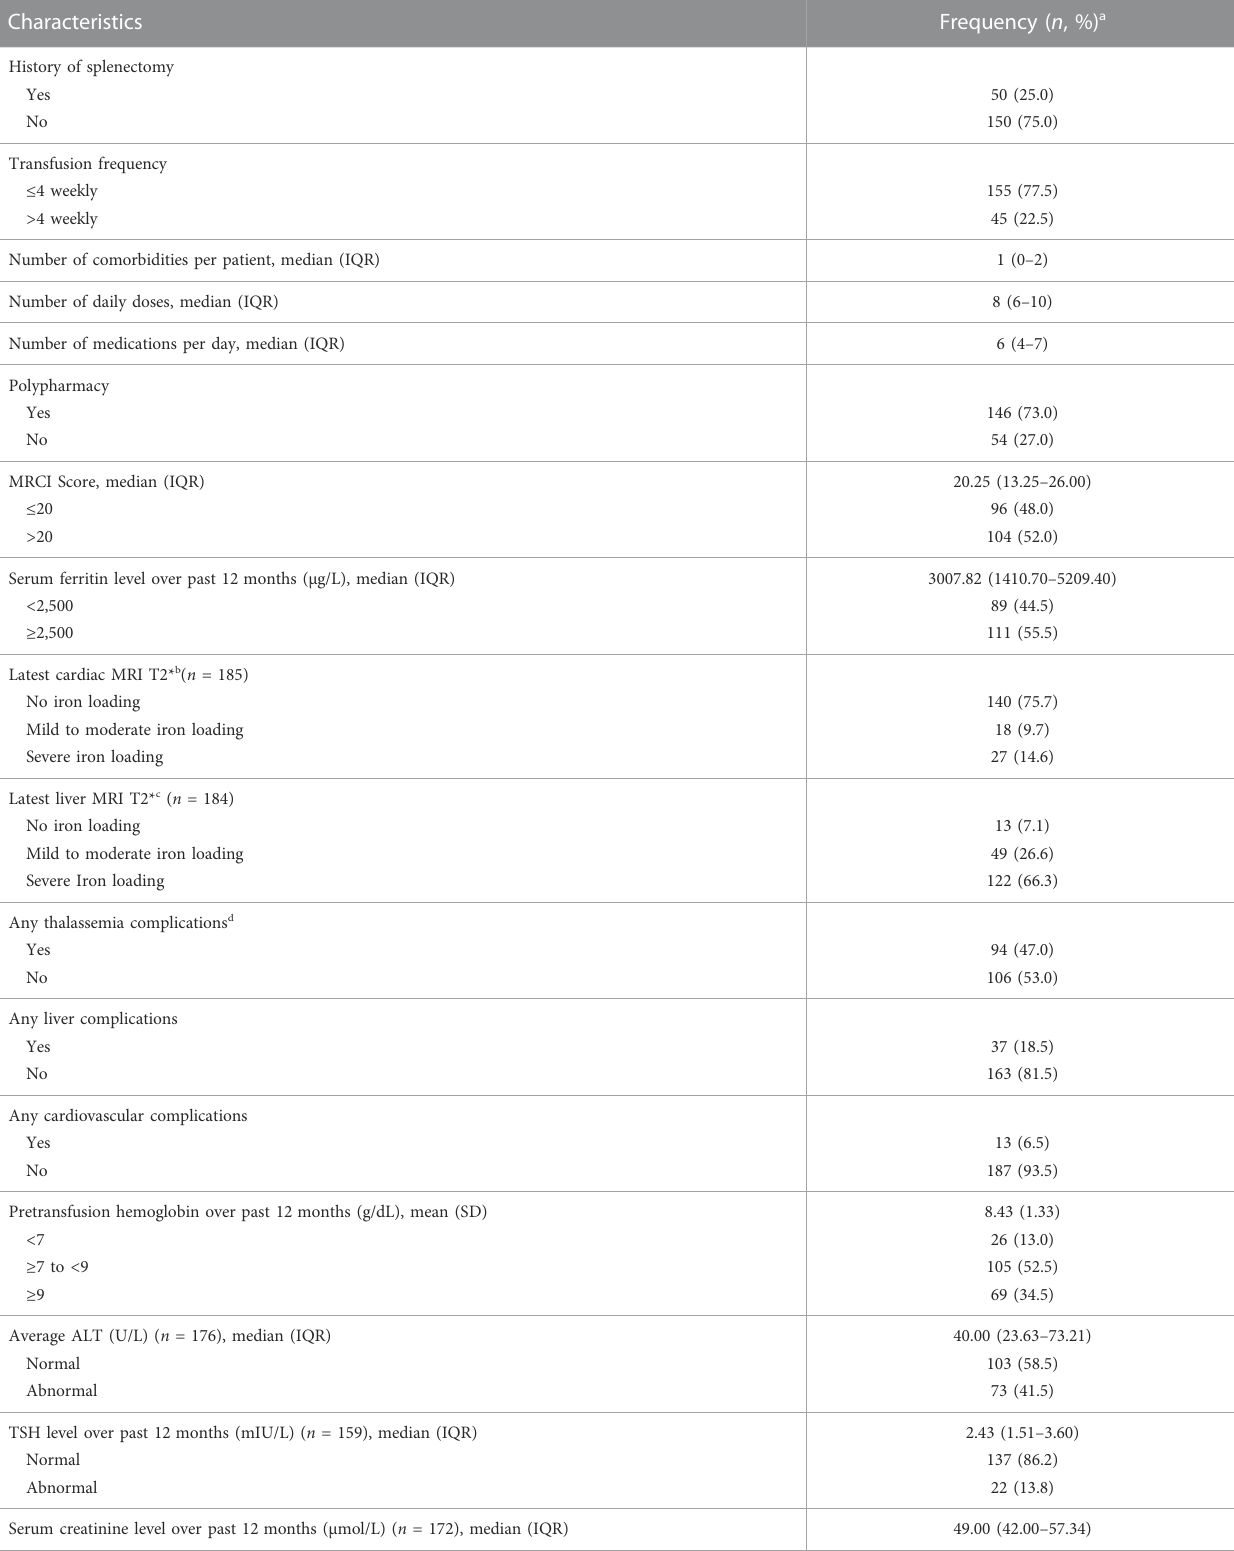
TABLE 2 Clinical characteristics of associated with transfusion dependent thalassemia participants ( n =